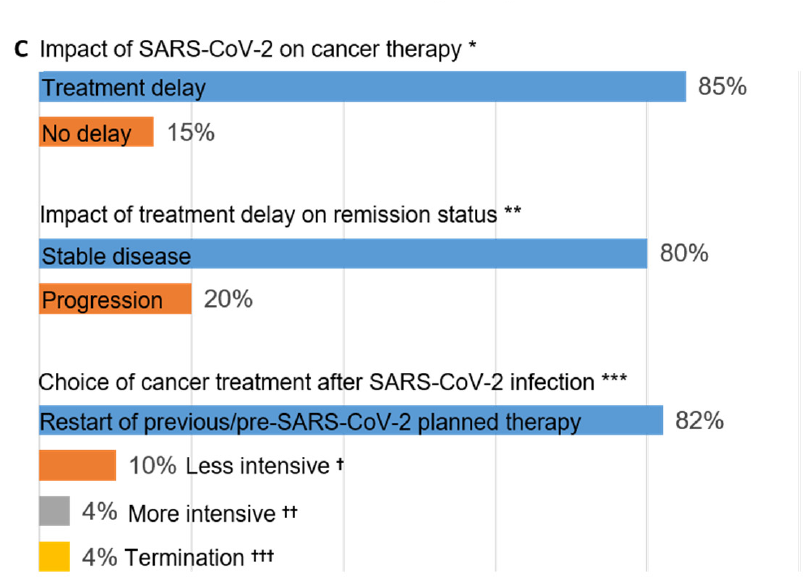
Figure 3. ( A ) Overall survival in the 63 cancer patients with SARS-CoV-2 infection from this study. ( B ) Cumulative percentage of deaths due to COVID-19 and cancer. ( C ) Impact of SARS-CoV-2 infection on the subsequent cancer course. * Results of 54 out of 63 patients with ongoing or planned cancer therapy before testing positive for SARS-CoV-2; 85% of those were observed with delay of cancer therapy. ** Results in 46 patients with treatment delay due to SARS-CoV-2 infection; 80% had stable and 20% progressive disease; *** Illustration of subsequent cancer treatment in 45 SARS-CoV-2 survivors with active malignancy requiring further treatment. † 10% of these patients received less intensive therapy due to deterioration of general condition following COVID-19; †† 4% received more intensive therapy due to progressive disease following therapy delay after SARS-CoV-2 infection; ††† 4% experienced termination of therapy due to poor general condition following COVID-19.